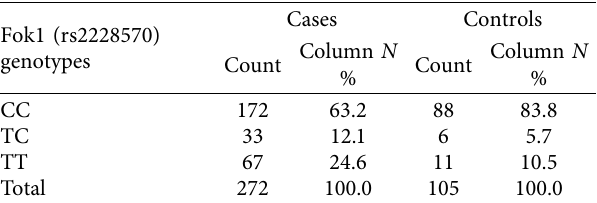
Table 4: Association of genotypes rs2228570 based on Fok1 RFLP evaluation in the caries-active cases and caries-free controls.